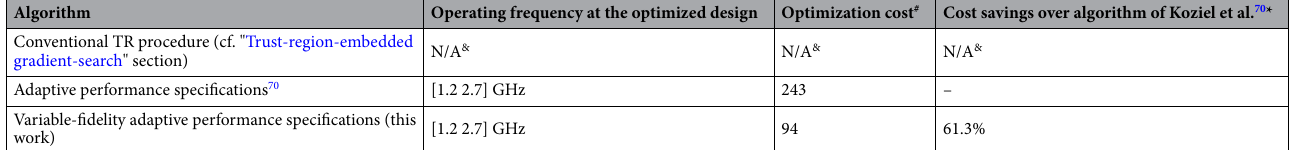
Table 4. Optimization results for Circuit II. $ Objective function computed as in (2). # Cost expresses in equivalent number of high-fidelity EM simulations. & The algorithm failed to identify a satisfactory design, in particular, align the circuit operating frequency with the target. *Relative computational savings in percent w.r.t. the algorithm of 70 .